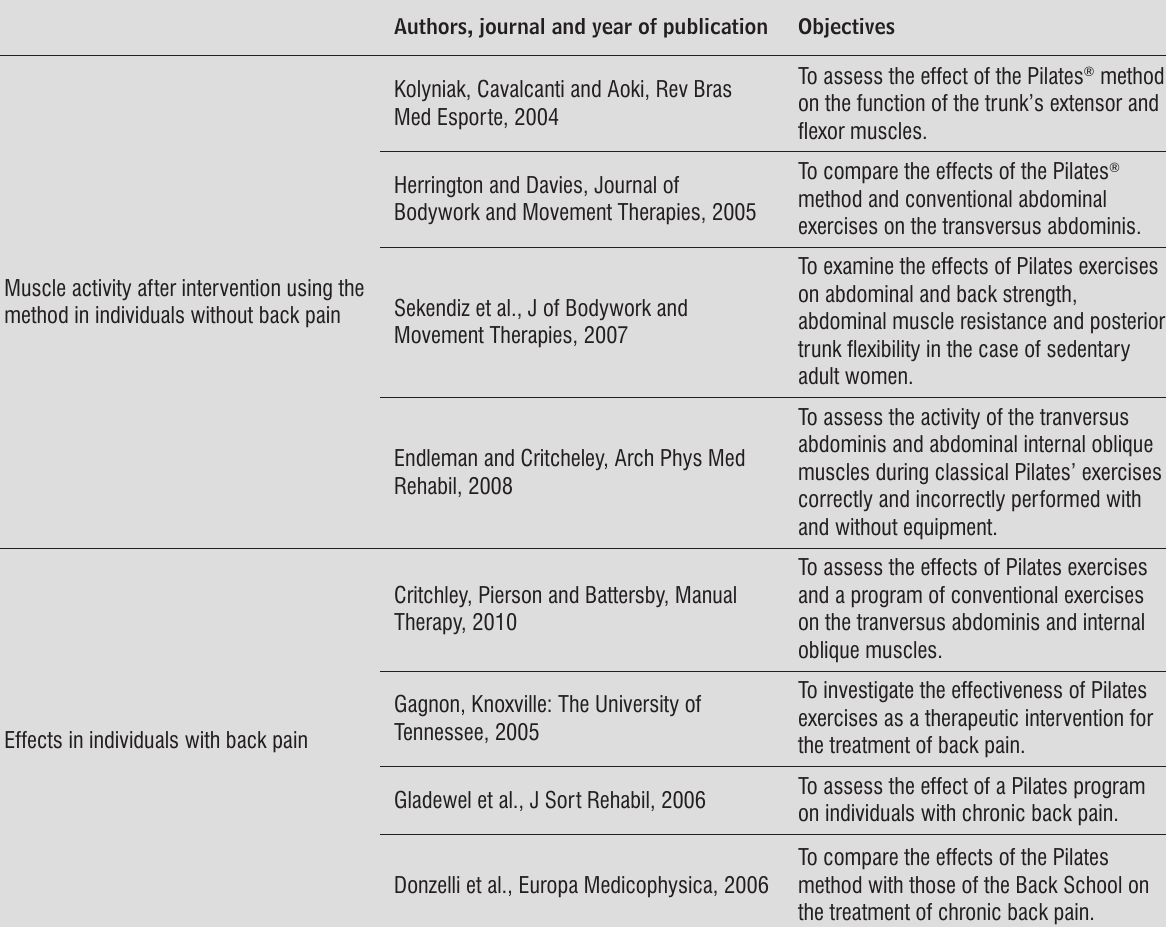
Table 3 - Stabilization exercises based on the Pilates ®